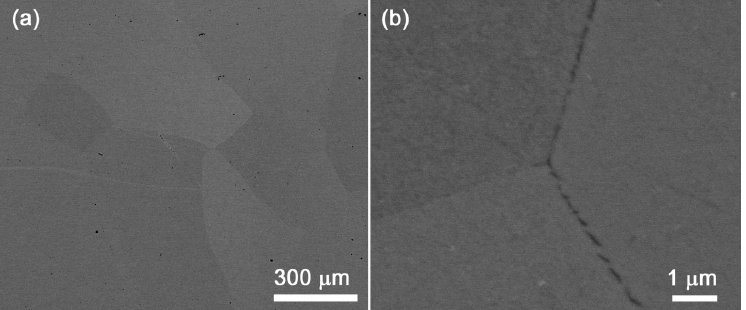
Figure 15. SEM micrograph (back-scattered electrons) of HfNbTiVZr alloy annealed at 1200 °C: ( a ) an overview of the microstructure, ( b ) a detail of the grain boundary enriched in V.